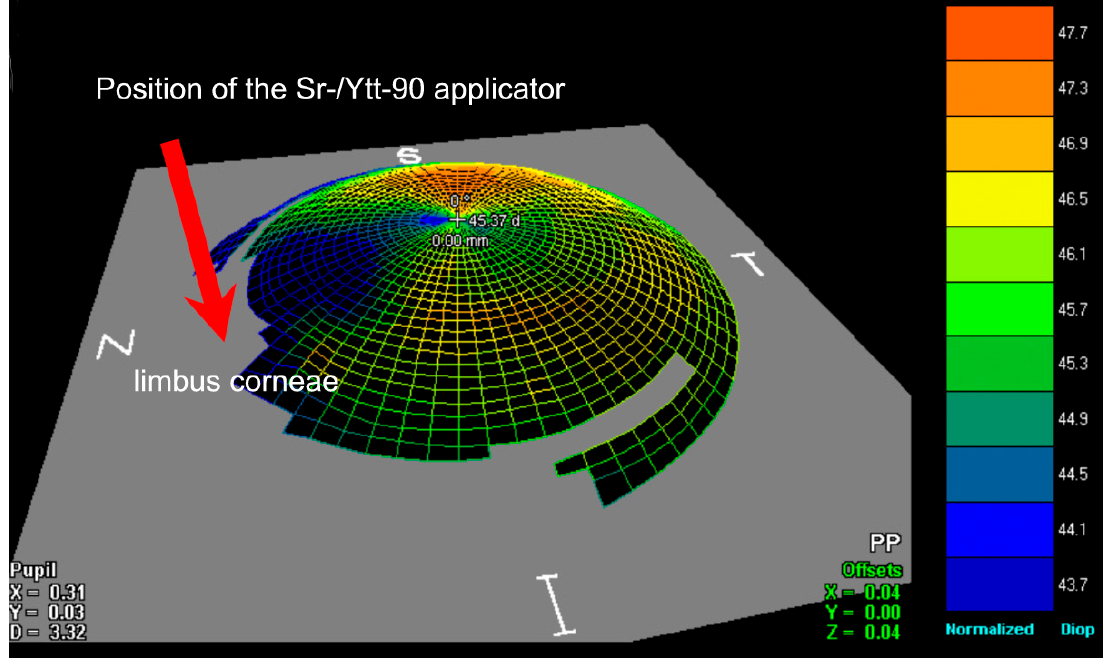
Figure 4. Topographical, schematic illustration shows the location on the nasal corneal limbus where the radiation applicator was placed. Note the cornea flattens in the area of the pterygium.